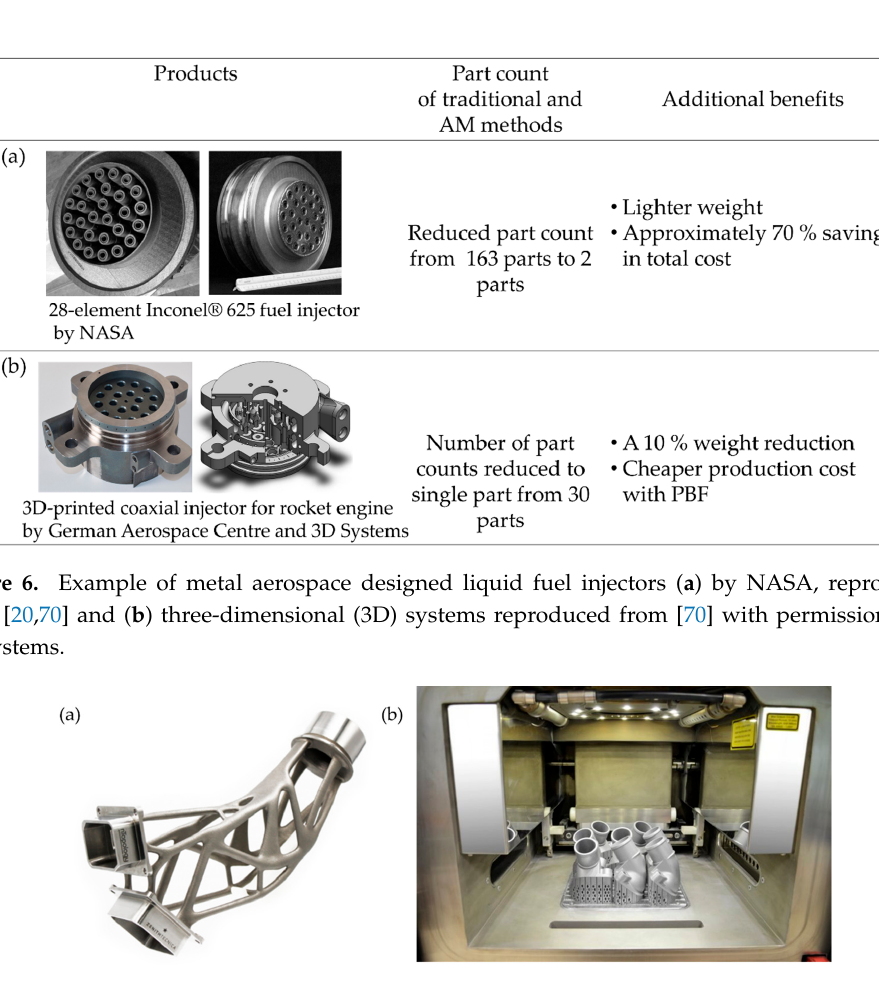
Figure 7. Representation of optimized ( a ) titanium spacecraft bracket, reproduced from [44] with permission from nTolology and ( b ) aluminum/silicon printed thermostat covers attached to the build platform. Reproduced from [71] with permission from Daimler AG.